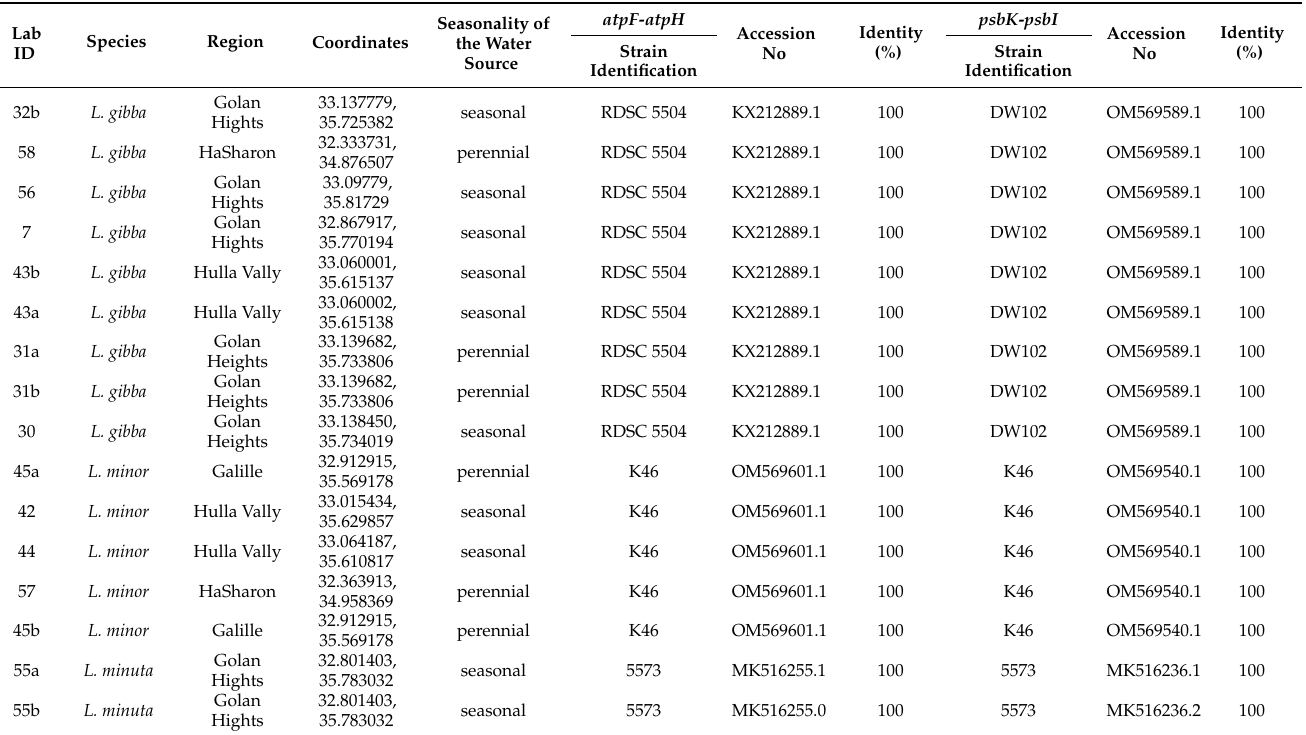
Table 2. DNA identification of the duckweed isolates using atpF - atpH and psbK - psbI barcodes. Identification was conducted using the NCBI